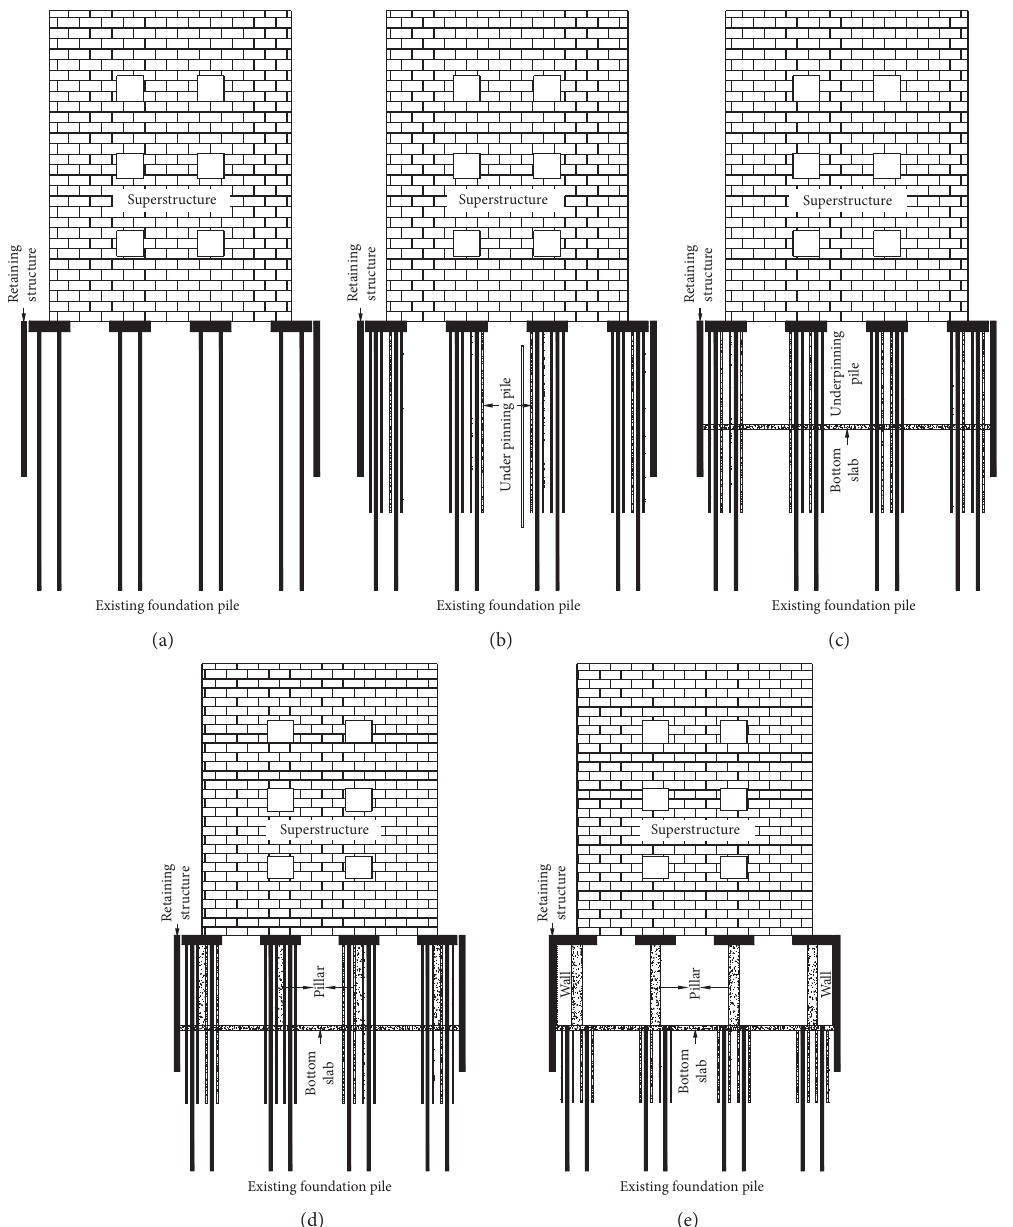
Figure 1: The sketch of the construction process for excavation beneath the existing building. (a) Retaining structure. (b) Underpinning pile. (c) Excavation. (d) Cast pillar. (e) Cutting